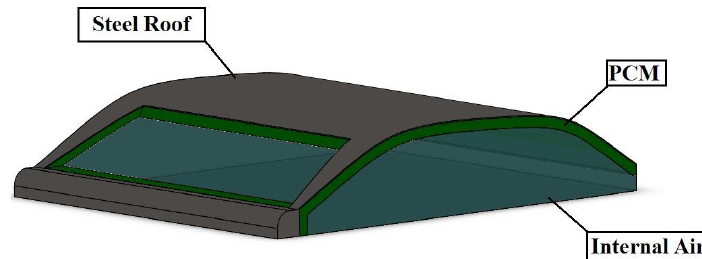
Figure 1. The CAD